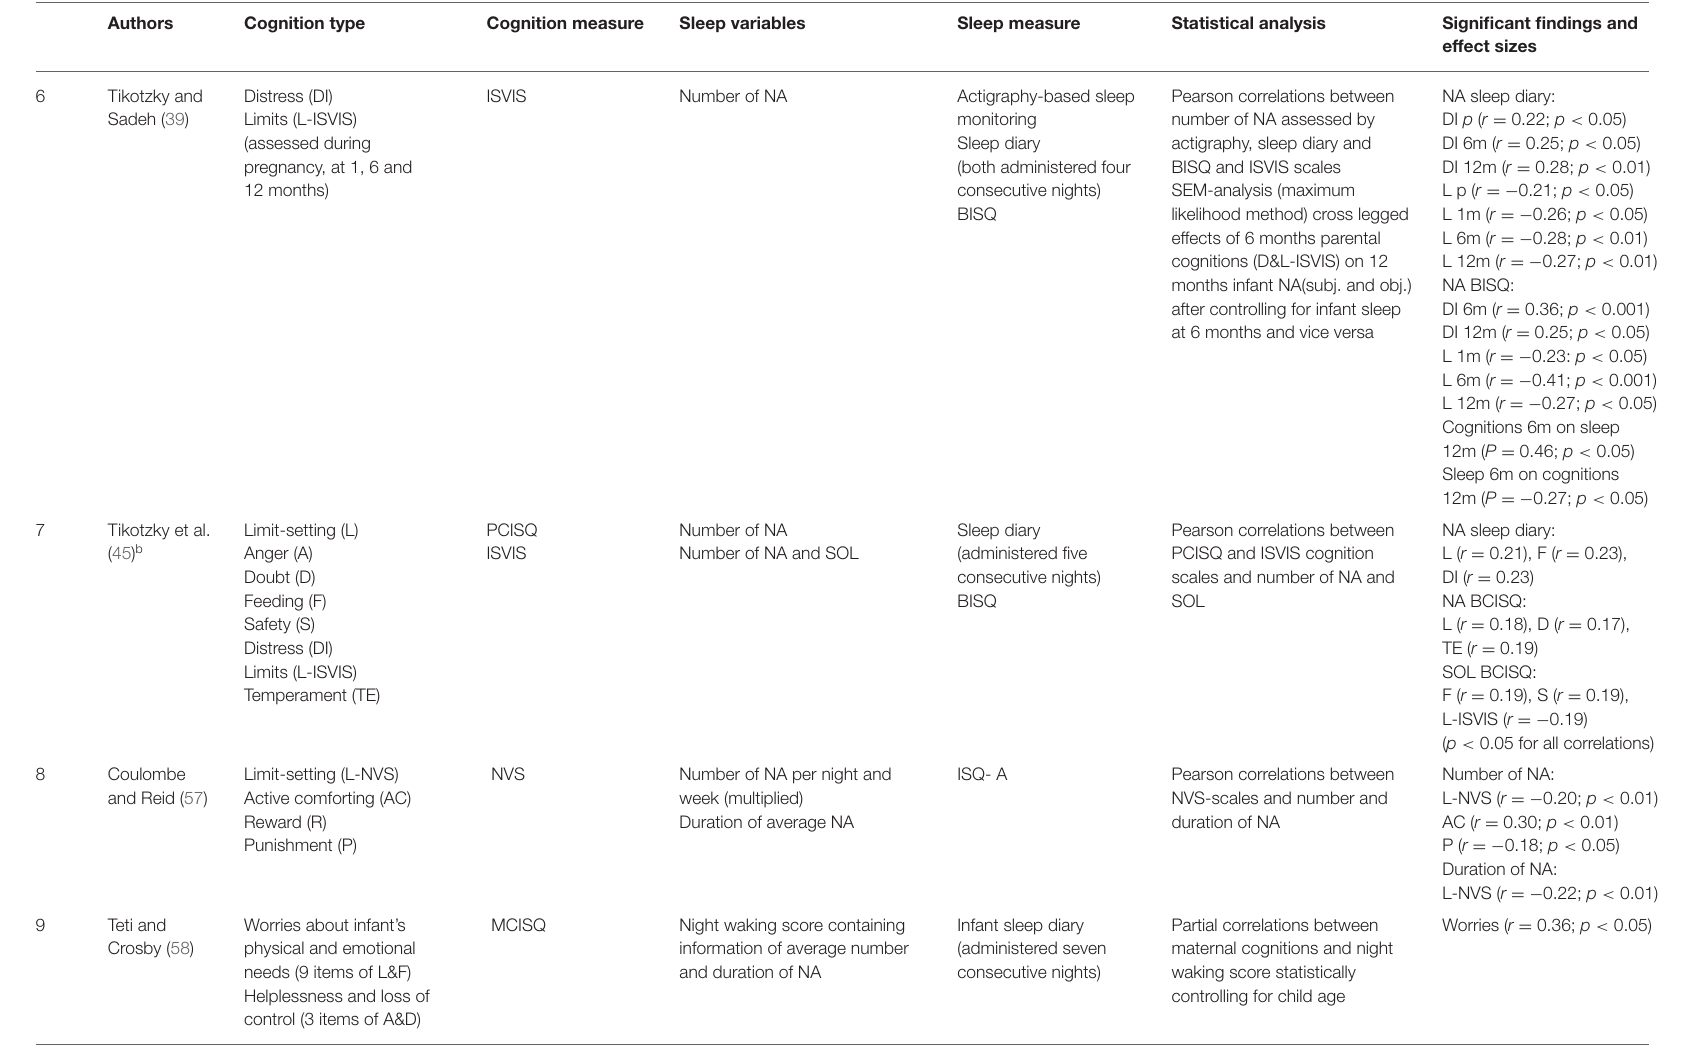
Worries ( r = 0.36; p <